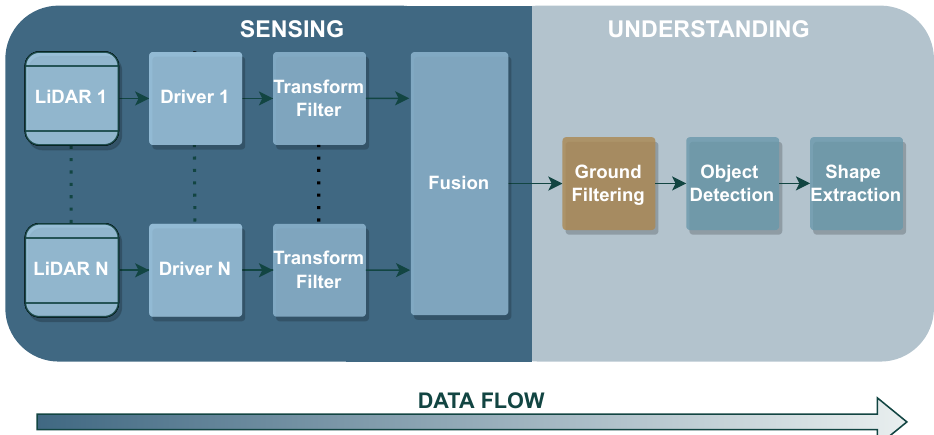
Figure 3. LiDAR processing